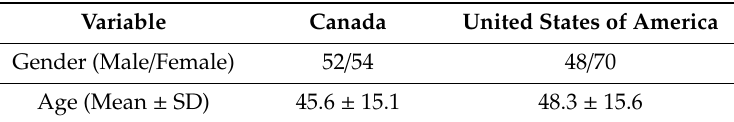
Table 1. Participant characteristics.